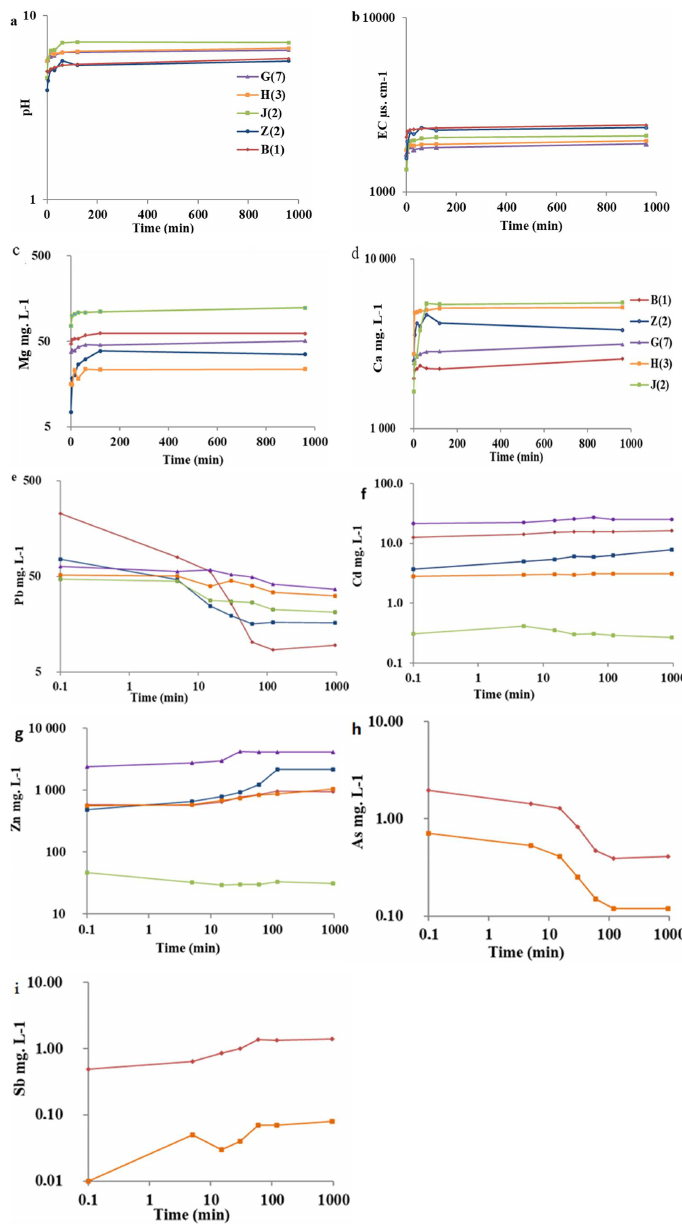
Figure 4. Variation of ( a ) pH and ( b ) EC and ( c ) Mg, ( d ) Ca, ( e ) Pb, ( f ) Cd, ( g ) Zn, ( h ) As and ( i ) Sb concentrations in the leachates during extraction with LMWOAs. pH: The initial pH of the organic acid solution is 2.8. At the beginning of the test, the lowest pH in soil leachate was noted in Z(2) with a value of 3.9. At the end of the lixiviation experiment (16 h), the pH value varied between 5.8 and 7.2 for the different soils (Figure 4a). The lowest pH values were found in Hammam Zriba (Z2) and the highest values were observed in Jalta. Conductivity. Leaching solutions were characterized by a rapid increase in EC dur- ing the first hour and then stabilized with a small increase until the end of the test (Figure 4b). The highest values were found for samples of Hammam Zriba and Sidi Bouaouane (2430 μs cm −1 and 2340 μs cm −1 , respectively). The EC of these soils could be explained by the presence of relatively soluble minerals such as gypsum, calcite and dolomite. Mg. The overall trend of the curves looks similar to those of pH in shape, showing an increase up to a maximum during the fourth cycle (after 30 min), and then stabilizing with a very small variation in concentration until the end of the test (Figure 4c). The high- est concentration of Mg was found for the soil from Jalta (123 mg L −1 ), resulting mainly from the dissolution of dolomite. Ca. Ca concentrations show a rapid increase at the beginning of the test up to a max- imum and then stabilize with very little variation until the end of the test (Figure 4d). This